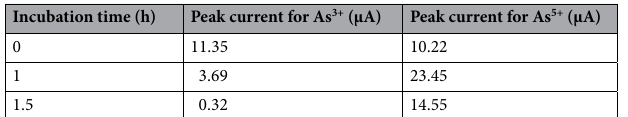
Table 3. Measured peak current during the exhaustive oxidation of As 3+ to As 5+ by A. xylosoxidans BHW- 15. The condition of DPV measurements was initial potential − 1.0 V, end potential 2.0 V, pulse width 50 ms, modulation 50 mV, and pulse period 0.1